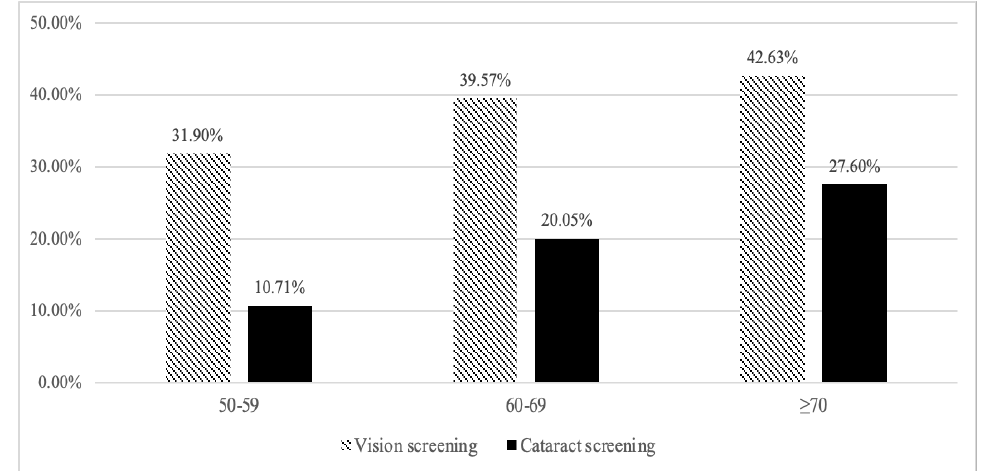
Figure 1. Age-specific Uptake Rate of services for Vision Screening and Cataract Screening.